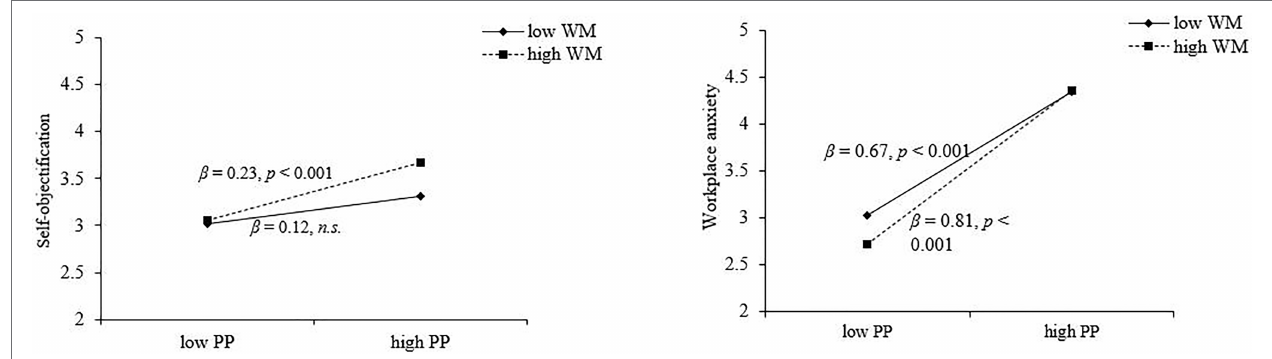
FIGURE 2 | The interaction between performance pressure (PP) and work meaningfulness (WM) on self-objectification and workplace anxiety.